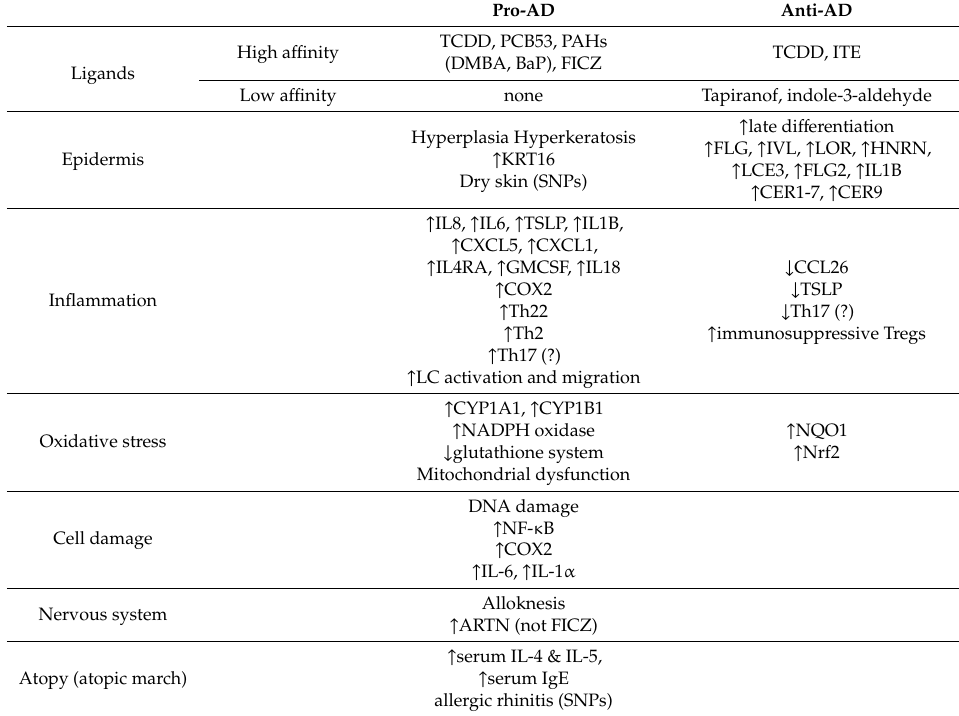
Table 1. Dual e ff ects of AHR in atopic